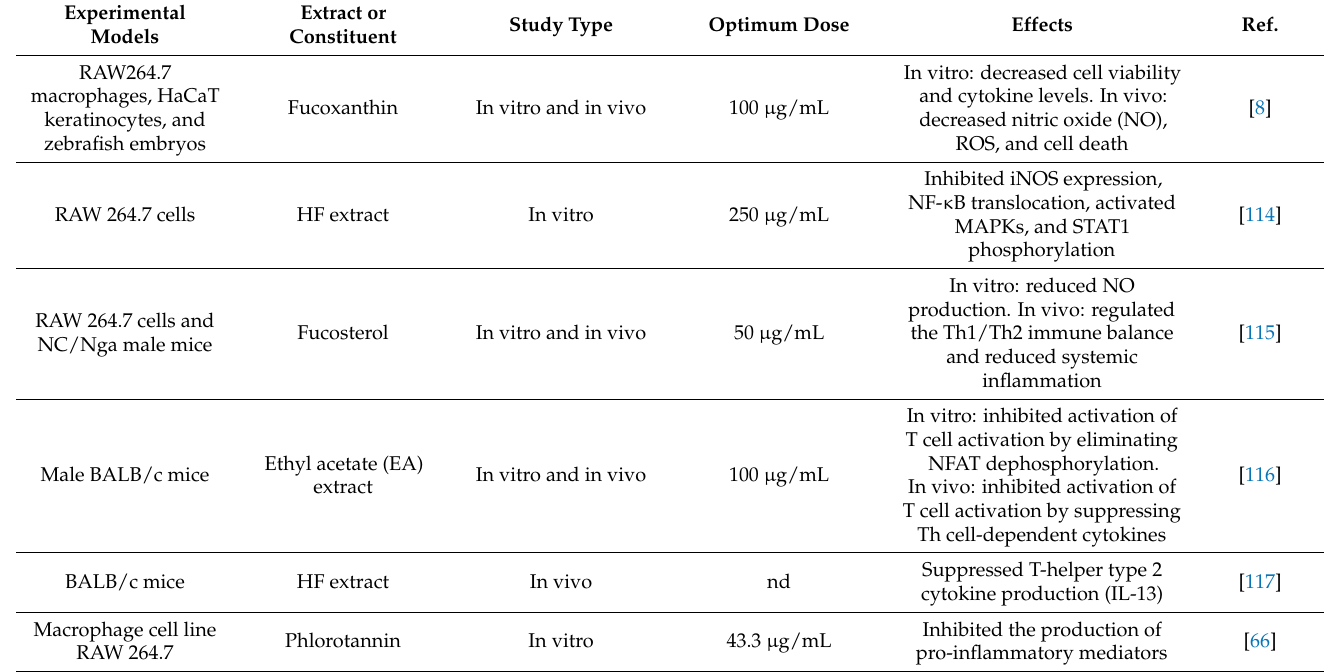
Table 8. Summary of the anti-inflammatory activity of H. fusiformis